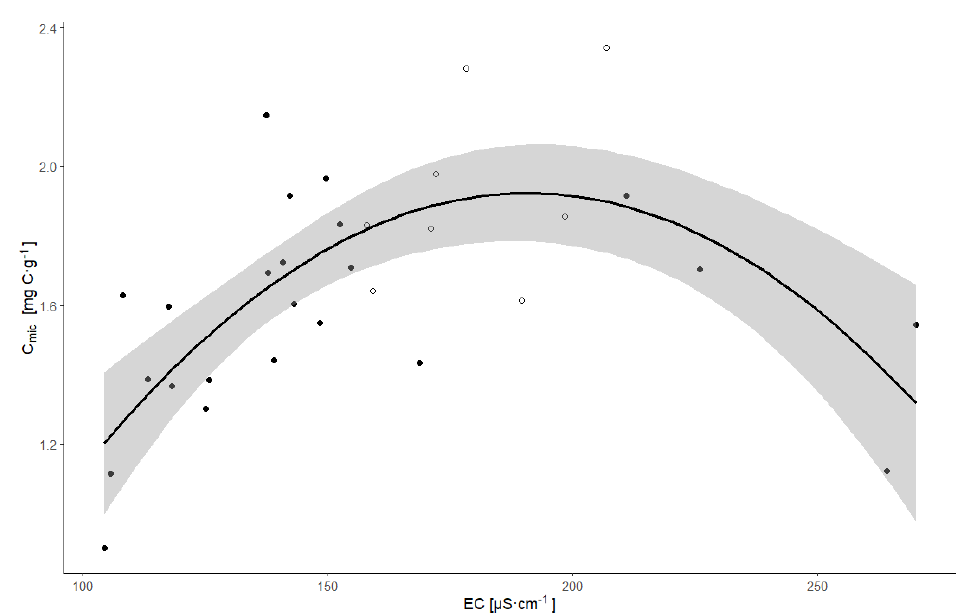
Figure 3. A quadratic regression model of the microbial-biomass carbon (C mic ) as dependent on soil electrical conductivity (EC) at Placek B site; the different levels of C:N are indicated by symbol fills (full for C:N range 4.5–6.9; hollow for C:N range 11.2–12.7).